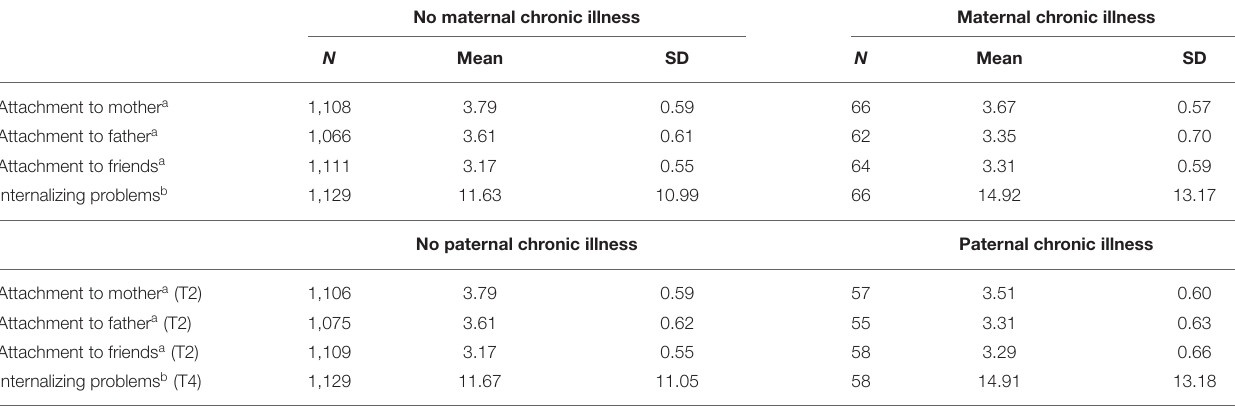
TABLE 2 | Descriptive statistics for the study variables according to parental chronic illness status ( N = 1,266).